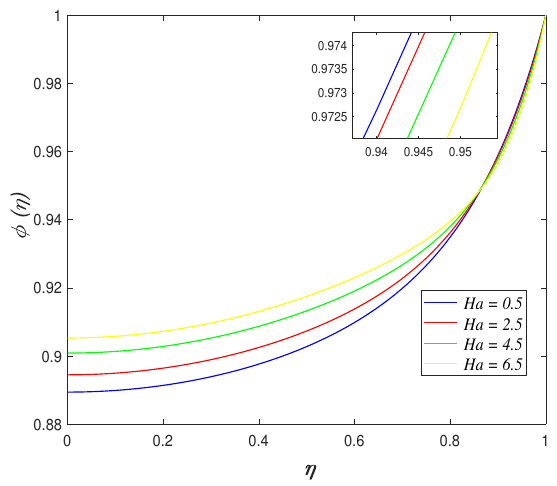
Figure 13. Impact of Ha on